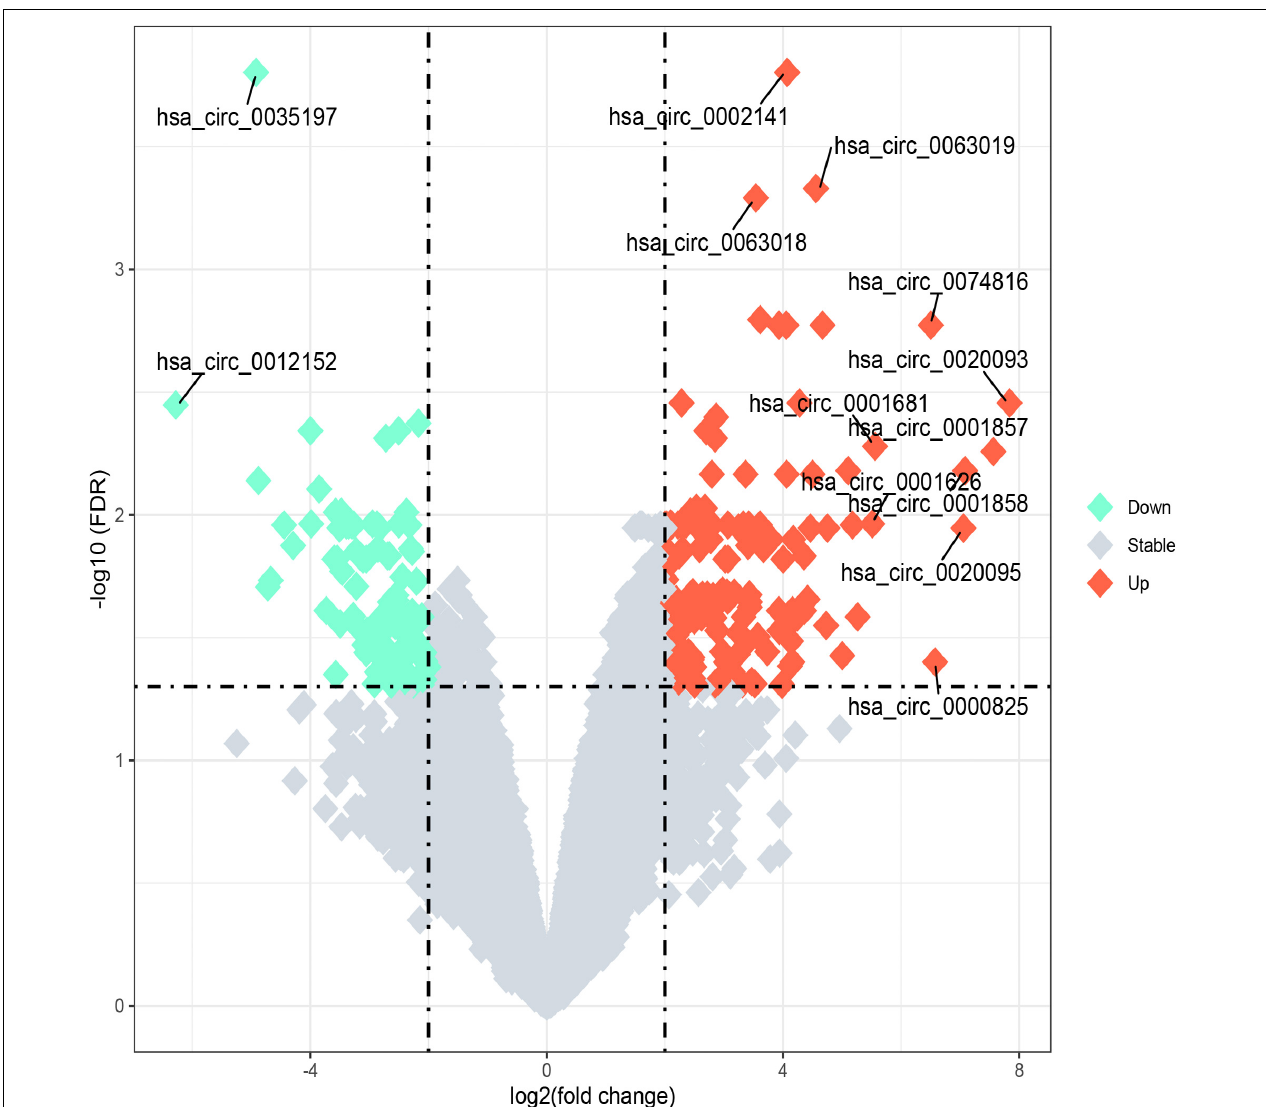
FIGURE 2 | Volcano plot of differentially expressed circular RNAs (circRNAs) between acute lymphoblastic leukemia (ALL) and acute myeloid leukemia (AML). “Log 2 (fold change)” is plotted on the horizontal axis, and “-log 10 (FDR)” is plotted on the vertical axis; that is, the larger the “|log 2 (fold change)|,” the greater the difference, and the larger the “-log 10 (FDR),” the more significant the statistical difference. Tomato and aquamarine, respectively, represent the upregulated and downregulated circRNAs with |log 2 FC| ≥ 2 and FDR < 0.05, while the gray represents the circRNAs with |log 2 FC| < 2 or FDR ≥